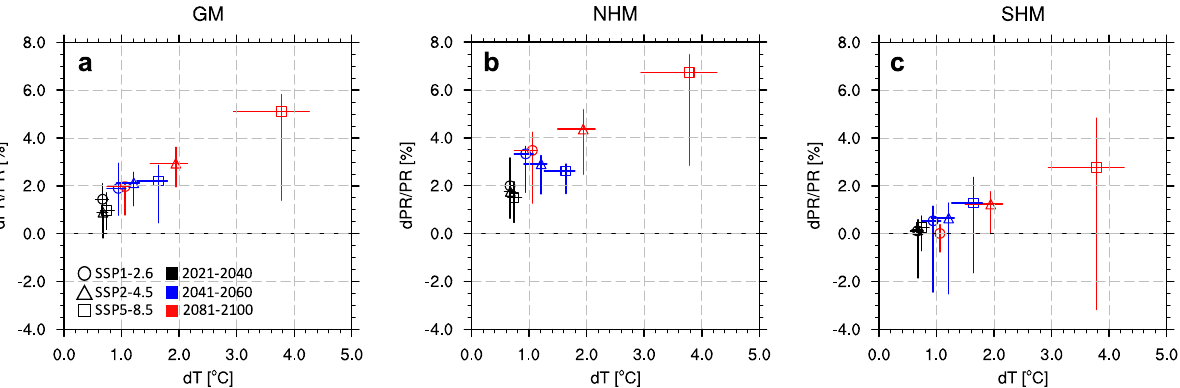
Fig. 1 Future changes in precipitation and global temperature over the global monsoon domain. a – c Median of multiple-model percentile changes in summertime precipitation (%) and global mean temperature (°C) over: a the global monsoon (GM), b the Northern Hemisphere monsoon (NHM), and c the Southern Hemisphere monsoon (SHM) domains. Changes are relative to the present period (1995 – 2014). Circles, triangles, and squares indicate three different future scenarios (SSP126, SSP245, and SSP585, respectively). The colors refer to the individual future periods: near term (black; 2021 – 2040), mid term (blue; 2041 – 2060), and long term (red; 2081 – 2100). Error bars show the range between the 25th and 75th